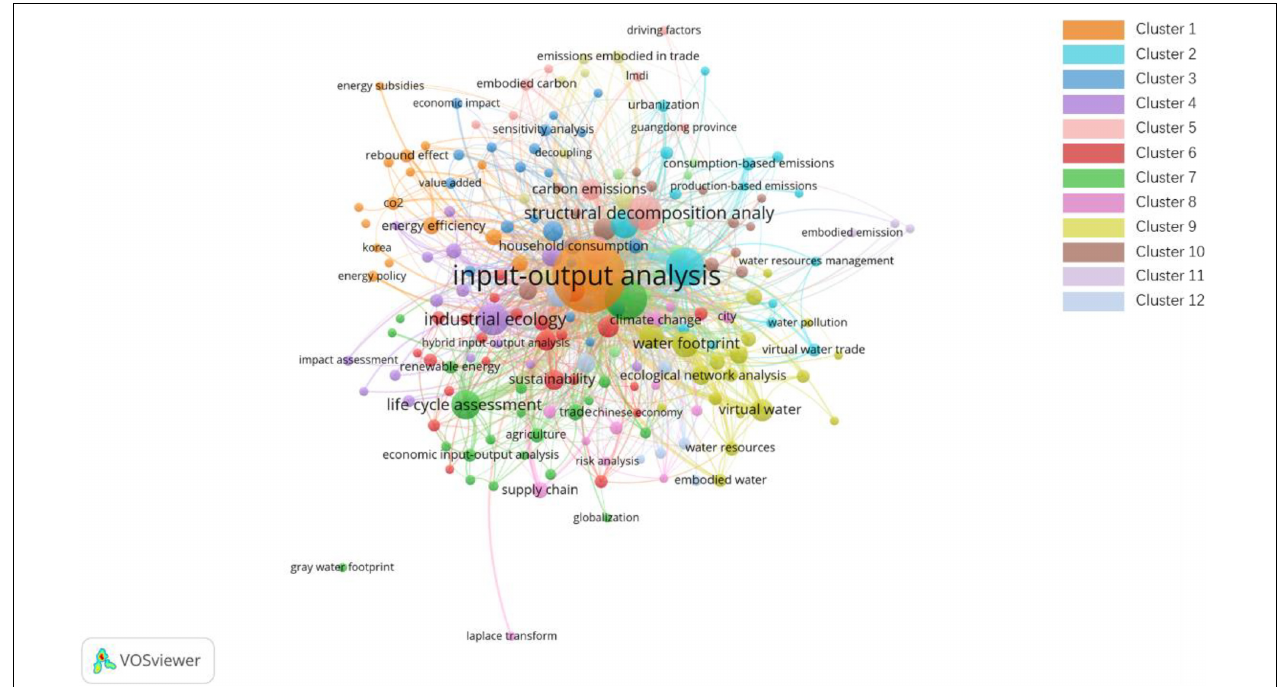
FIGURE 4 | Distribution of keywords in co-occurrence